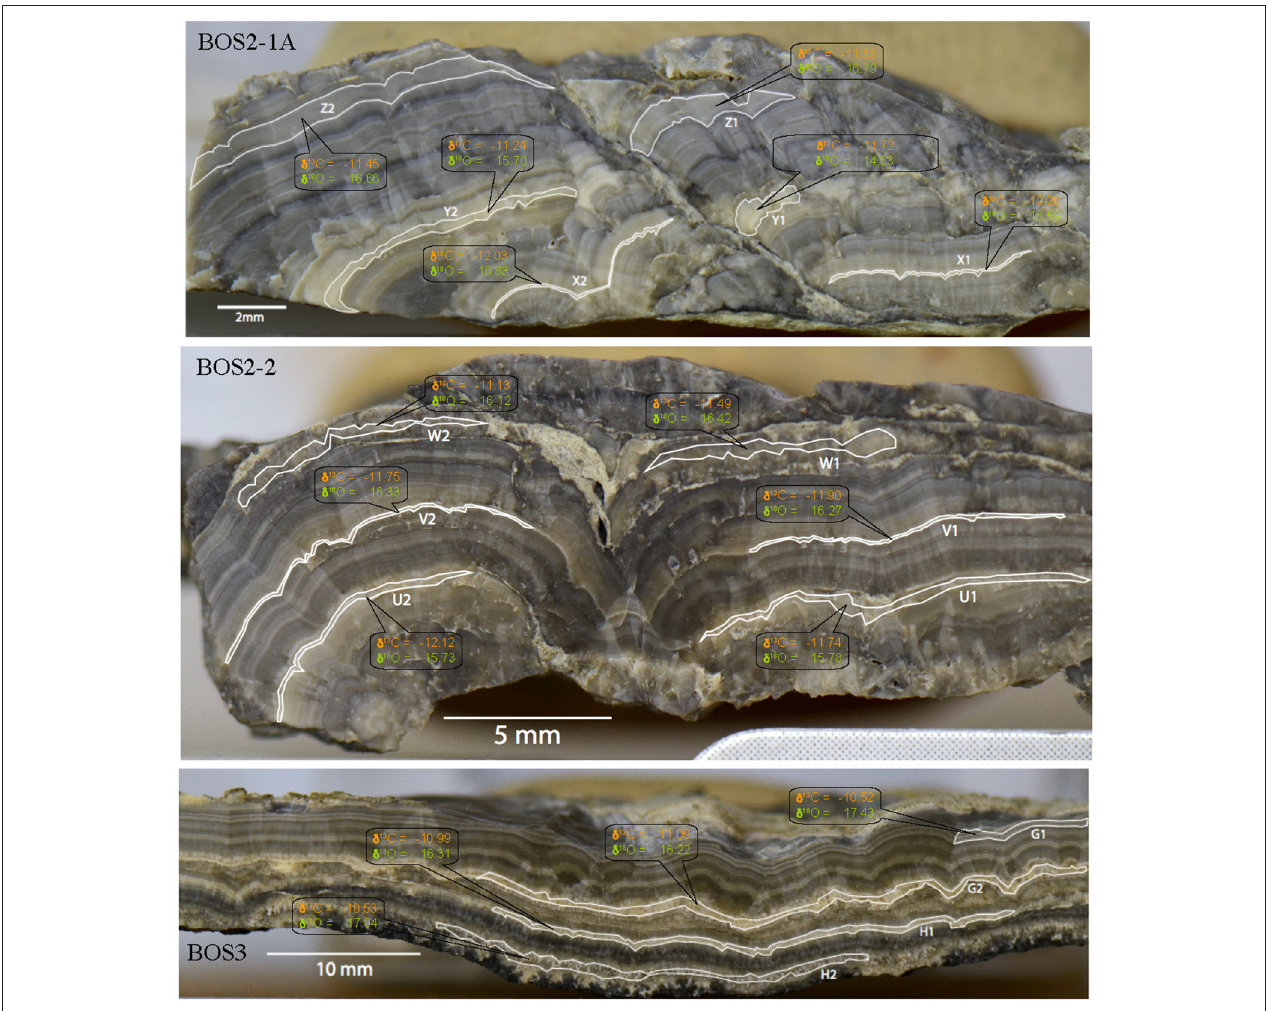
FIGURE 8 | Carbon and oxygen isotope values for the carbonate within samples BOS2-1A, BOS2-2, BOS3. Isotopic values are reported in the standard δ -notation in permil ( ‰ ) relative to VPDB and VSMOW for the carbon and oxygen isotopes, respectively.